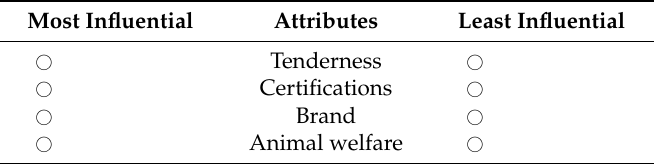
Table 2. Example of attributes subset. Respondents had to indicate which of the four presented attributes was considered the best and which worst. Most Influential Attributes Least Influential Tenderness Certifications (cid:35) (cid:35) (cid:35) (cid:35) Brand Animal welfare (cid:35)